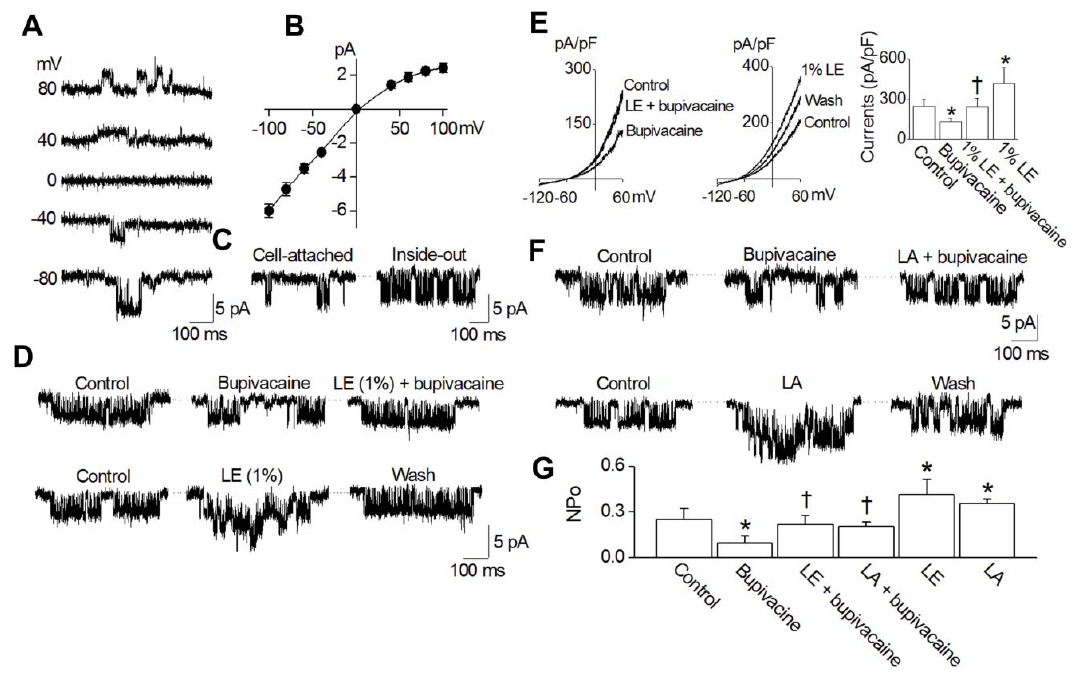
Figure 5. Direct effect of bupivacaine, lipid emulsion (LE) and linoleic acid (LA) on K ATP channels. ( A ): Current tracings typically observed from a cell-attached patch of HEK-293 cells transfected with rat Kir6.2 and SUR2A show single-channel openings at various membrane potentials in symmetrical 150 mM KCl conditions. ( B ): A current-voltage relationship of K ATP channels in 150 mM KCl is shown. Each point is the mean of five determinations. ( C ): Opening of K ATP channels in inside-out patches. A cell-attached patch was formed at −80 mV; then, the inside-out patch was formed. ( D ): Blocking of the bupivacaine-induced inhibition of K ATP channel activity by LE. In the inside-out patch, bupivacaine application (10 − 4 M) to the cytosolic side of the membrane inhibited channel activity, and the combined treatment with LE (1%) and bupivacaine (10 − 4 M) recovered the bupivacaine-induced inhibition of channel activity. LE alone activated K ATP channels, and the LE effect was reversible. ( E ): Effect of bupivacaine and LE on whole-cell currents of K ATP channels. Whole-cell currents showing the effect of bupivacaine and LE. A bar graph showing the effects of bupivacaine and LE on K ATP channels. ( F ): Blocking of the bupivacaine-induced inhibition of K ATP channel activity by LA (2 × 10 − 5 M). Currents were recorded as in ( D ) except for LA treatment. ( G ): Summary of K ATP channel activity by bupivacaine, LE, and LA alone and combination treatment. Data are expressed as the mean ± SD ( n = 5). Data were analyzed using one-way analysis of variance (ANOVA) followed by post hoc comparisons using Tukey’s test. n indicates the number of independent experiments. * p < 0.05 versus control. † p < 0.05 versus 10 − 4 M bupivacaine alone. The currents measured at +80 mV of pipette potential were